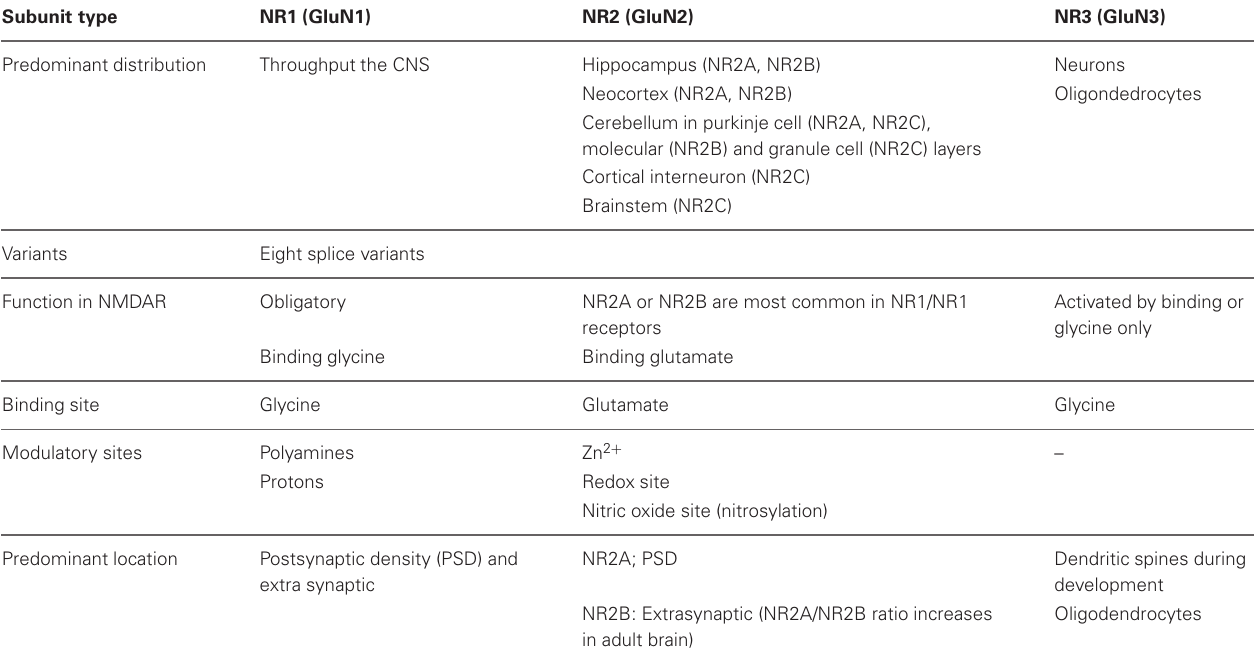
Table 1 | NMDA receptor subunits (NR1,NR2 and NR3) of mRNA distribution and their functions. (Adapted from Benarroch, 2011). Subunit